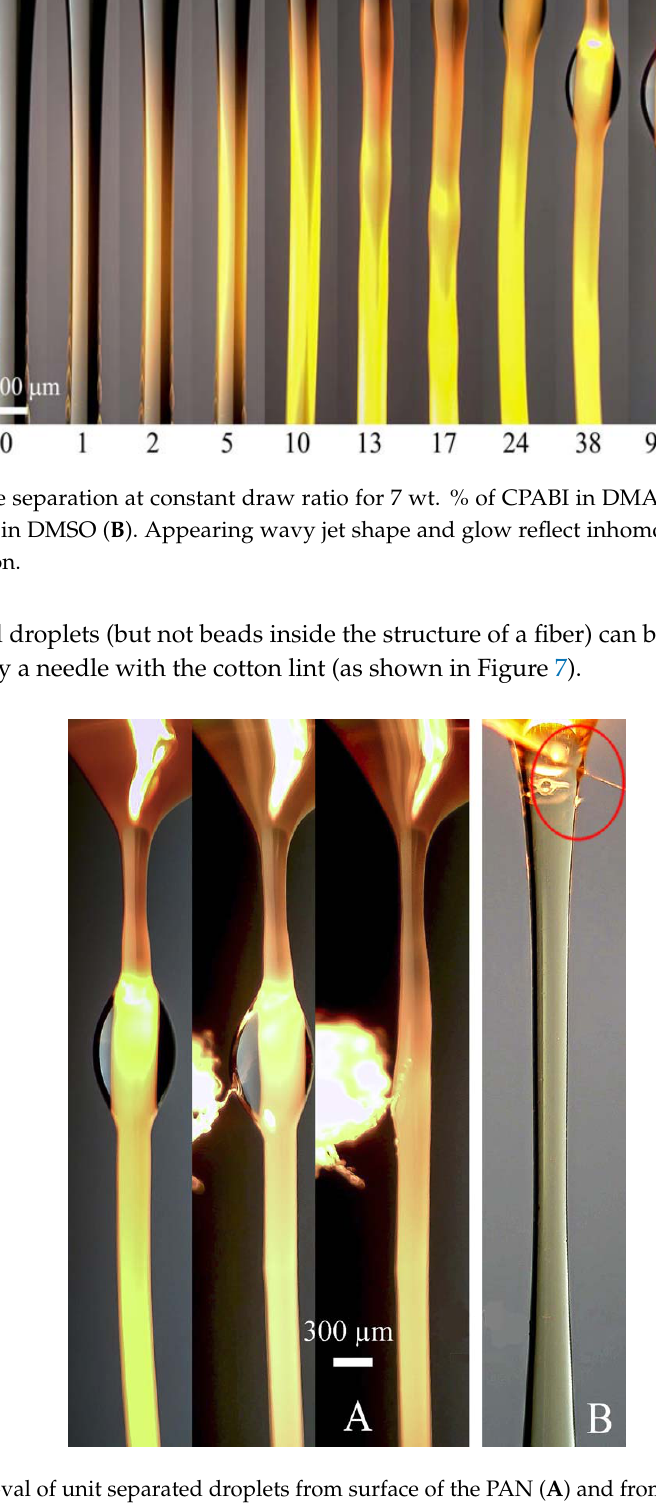
Figure 8. Removal of unit separated droplets from surface of the PAN ( A ) and from the Taylor cone in CPABI fiber spinning ( B ).